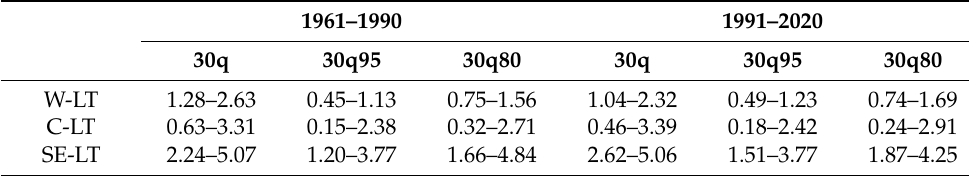
Table 2. Low-flow indices by the different regions and periods.